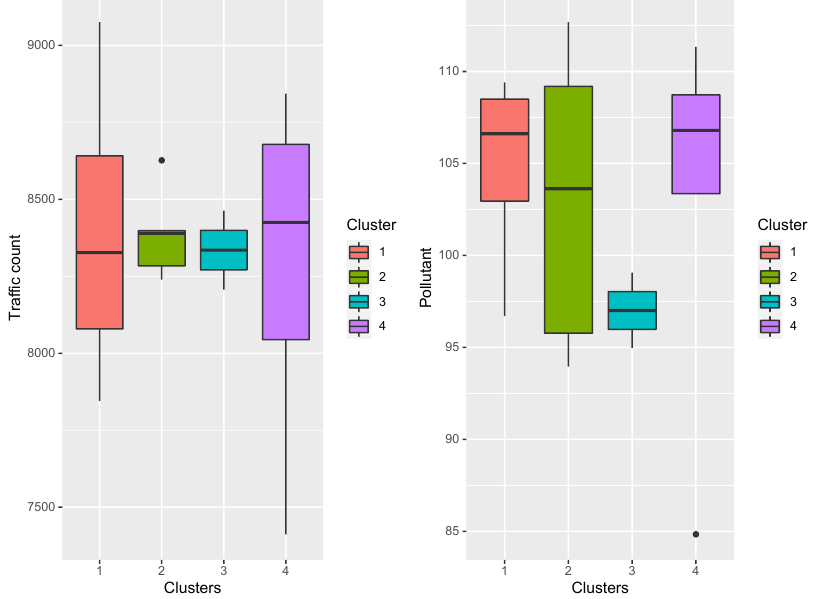
Figure 20. Clustering results applied to several weeks of data and visualization of NO 2 and traf- fic